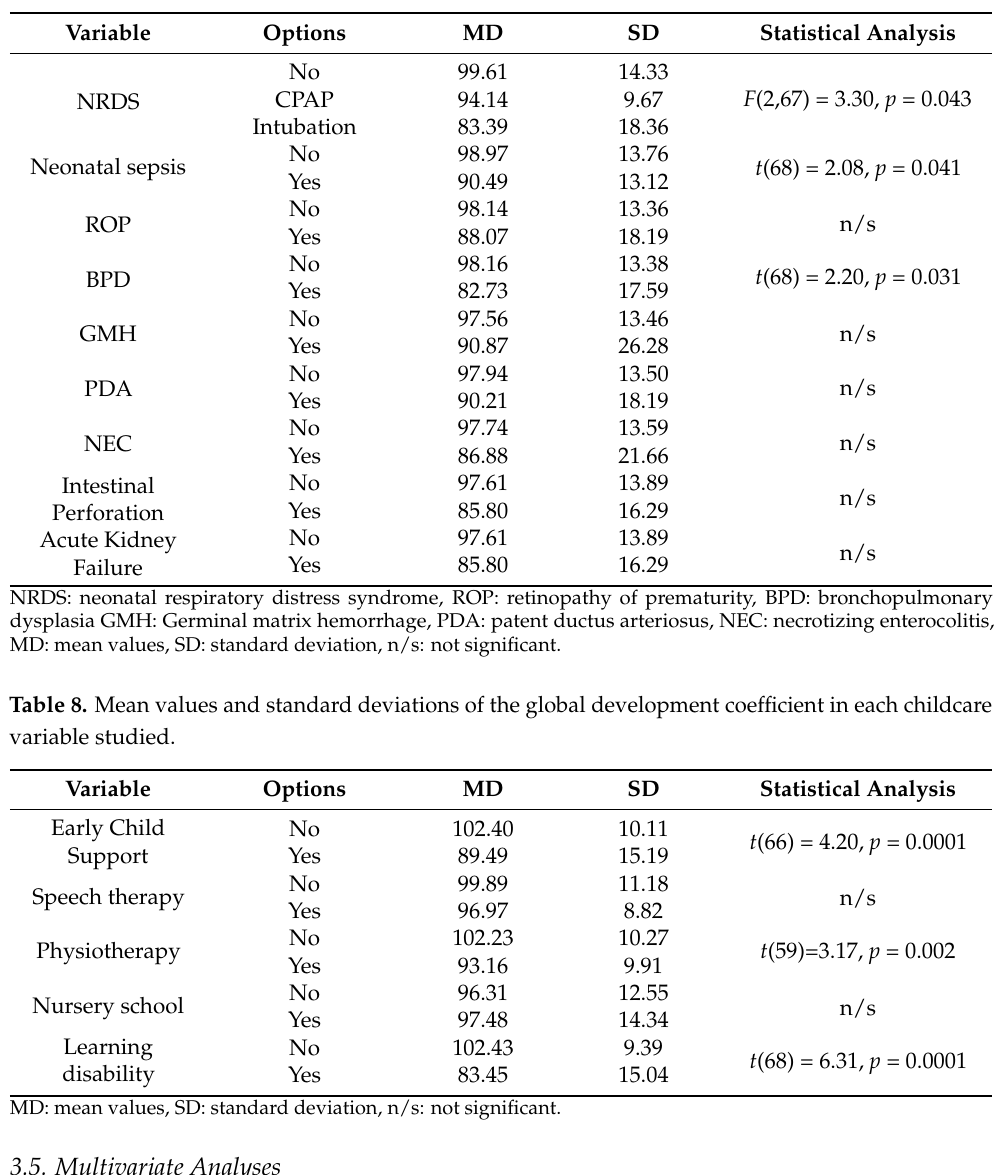
Table 7. Mean values and standard deviations of global development coefficient in each neonatal outcome studied.